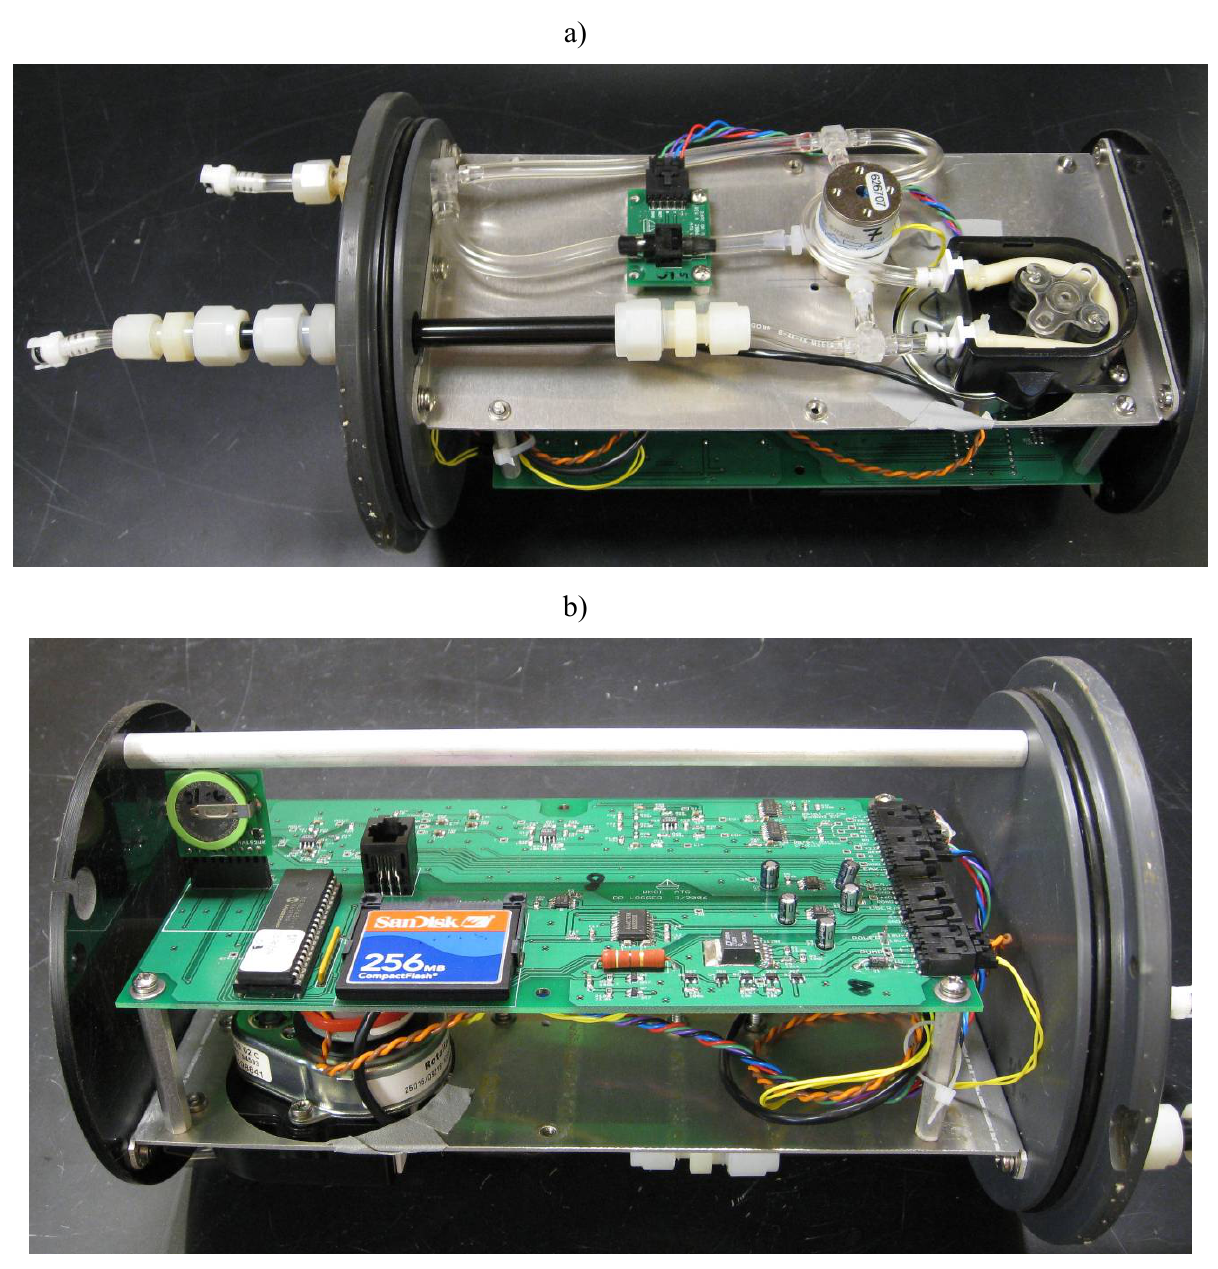
Figure 3. a) The internal fluid system mounted to the chassis – clockwise from upper left: groundwater port, DP cell with driving circuit board, solenoid valve, peristaltic pump, 545 CT cell feeding through the end cap to the surface water port; b) The motherboard of the logger mounted to the instrumentation chassis. The small vertical circuit board on the far left is the real-time clock. Next to the clock is the PIC processor, then the Compact Flash card. Beneath the processor, the motor for the peristaltic pump can be seen. The connectors on the right side of the board handle all interconnections to batteries, sensors, fluid components, and the user serial